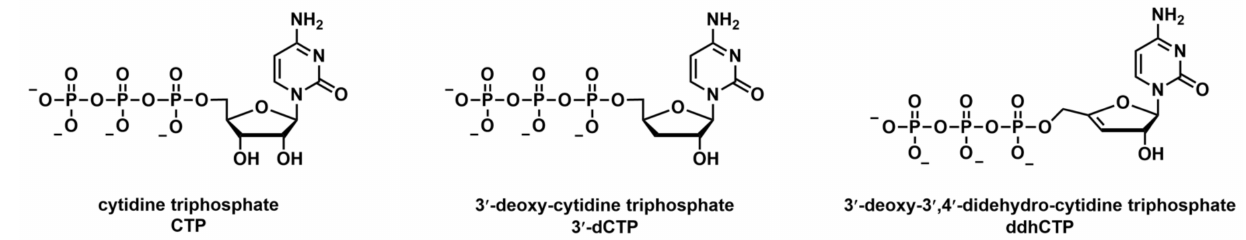
Figure 1. Chemical structures of CTP, and its chain-terminating analogues, 3 (cid:48) -dCTP and